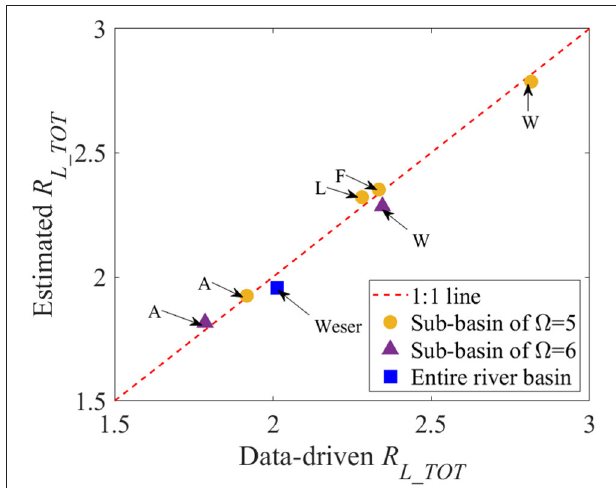
FIGURE 3 | Comparison of the Hortonian scaling ratio for total P tot loads input from point- and diffuse-sources, R L_TOT . Data-driven R L_TOT on the x-axis was originated from the data analyses, as presented in Figure 2A . Estimated R L_TOT on the y-axis was the result of the multiplicative model for R L_TOT as a power function of four Hortonian scaling ratios for P tot input loads from individual point- and diffuse-sources. In addition to the Weser River Basin (blue square), its six sub-basins with its corresponding final stream-order Ω = 5 or 6 (orange circle; purple triangle, respectively) are marked with the acronym of each name, as shown in Figure 1A